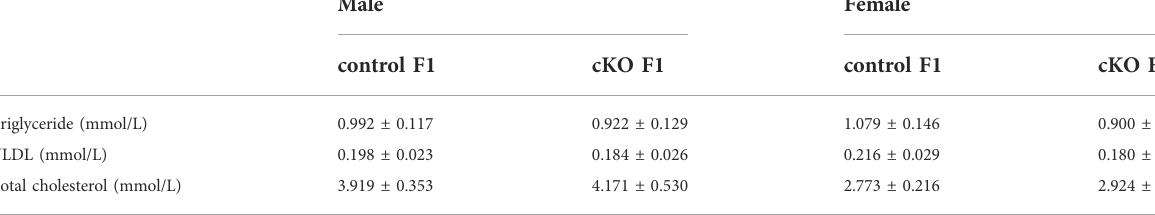
TABLE 2 The serum lipid concentrations of control and cKO F1 mice at 9-weeks of age.